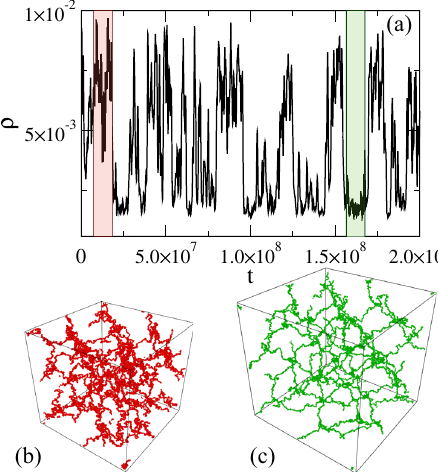
Fig. 3 Density fl uctuations and associated elastic properties. ( a ) Density fl uctuations as a function of time for the Diam - 0.35% network for P = P min = − 8.19 × 10 − 5 k B T / σ 3 and corresponding simulation snapshots of the compressed ( b ) and expanded states ( c ) among which the system fl uctuates. Source data are provided as a Source Data fi